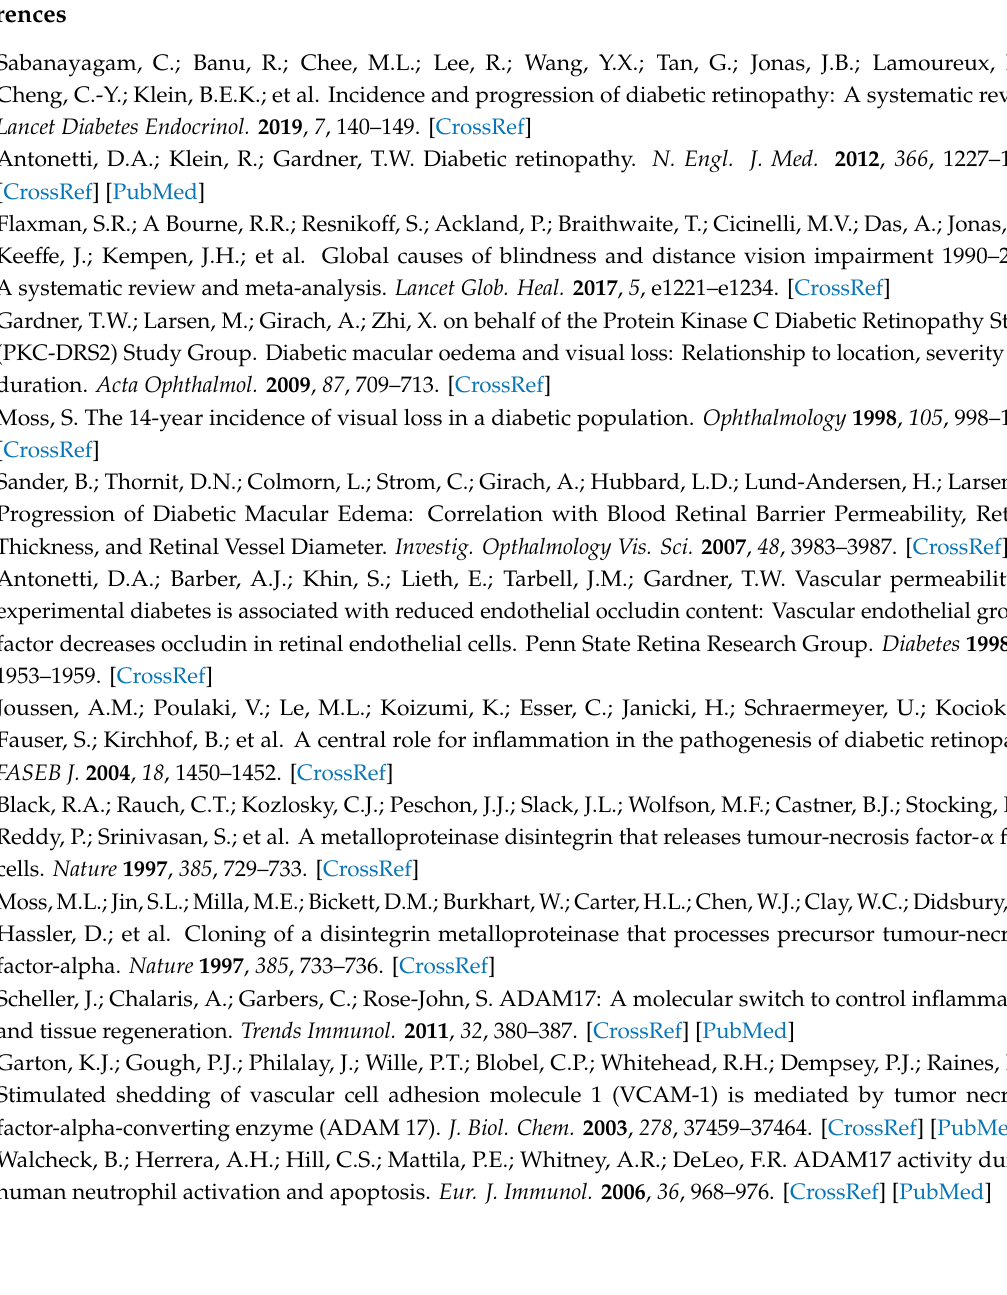
Table S1: Postmortem Donor History, Table S2: Average body weight and blood glucose levels in control and diabetic